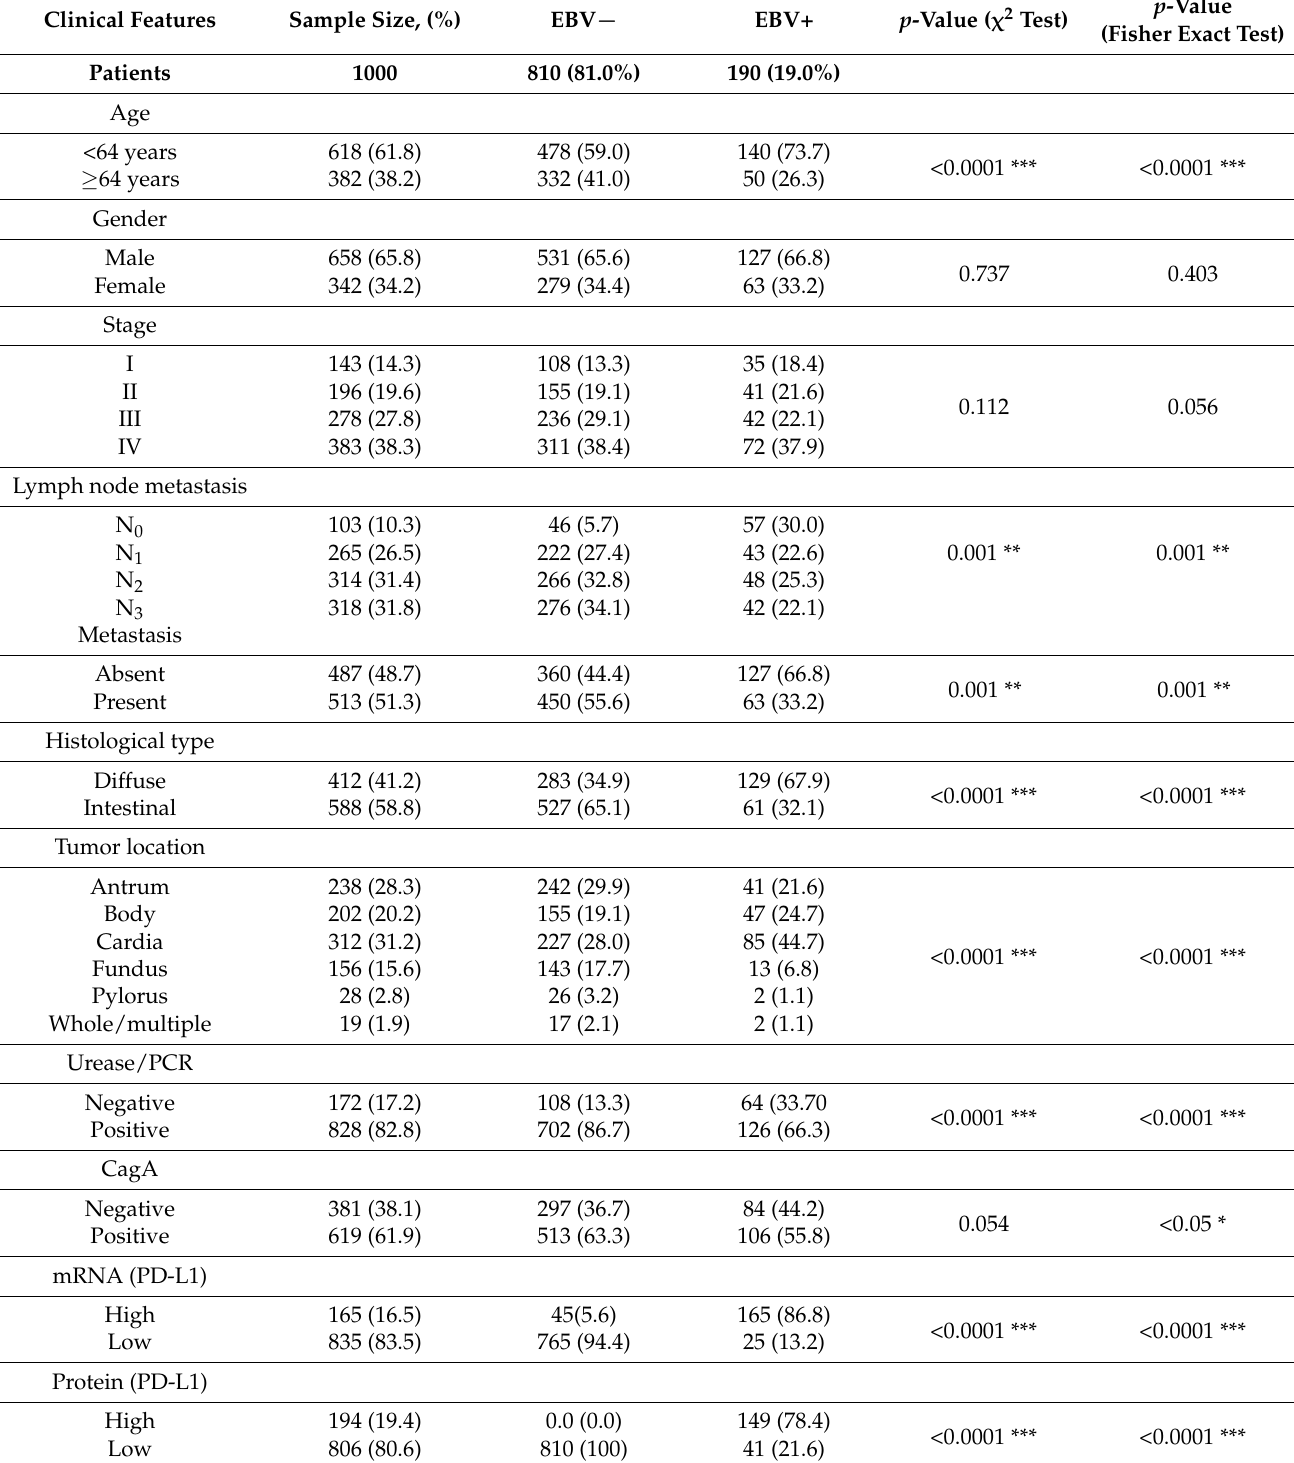
Table 2. EBV status and clinicopathological